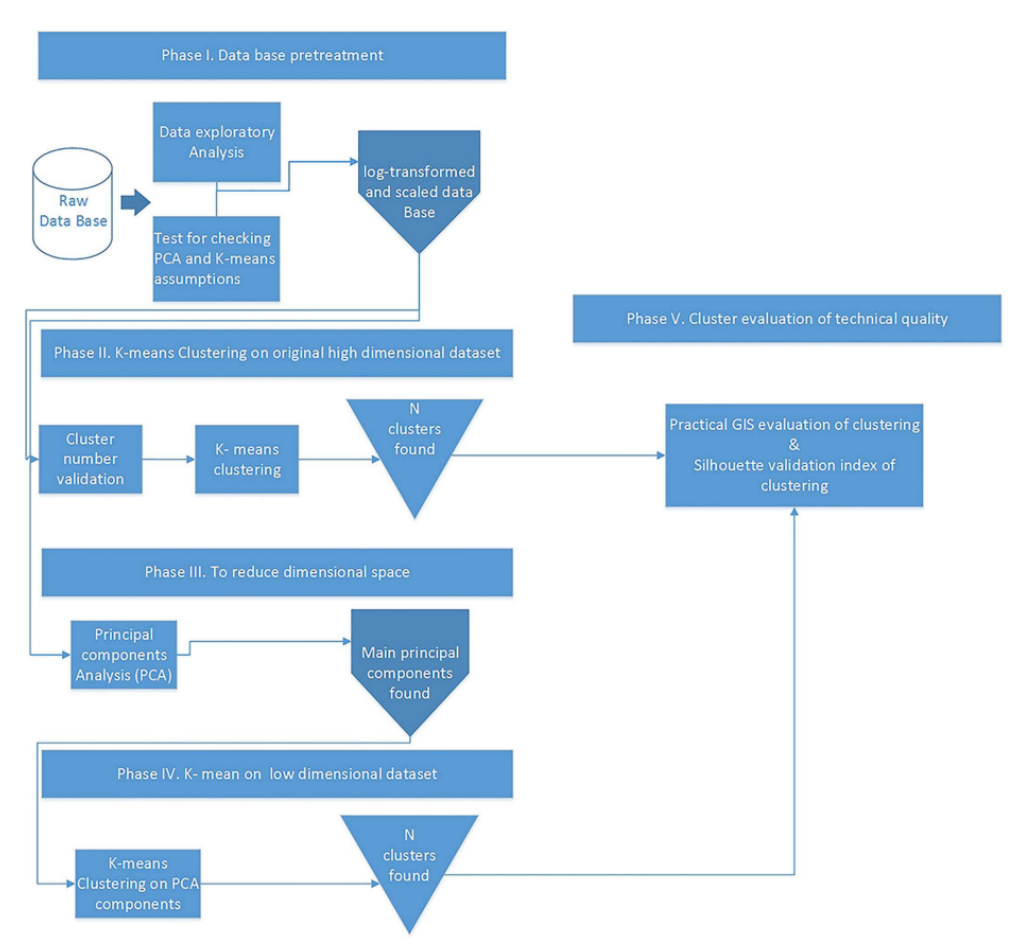
Figure 2. K-means clustering processes followed in the